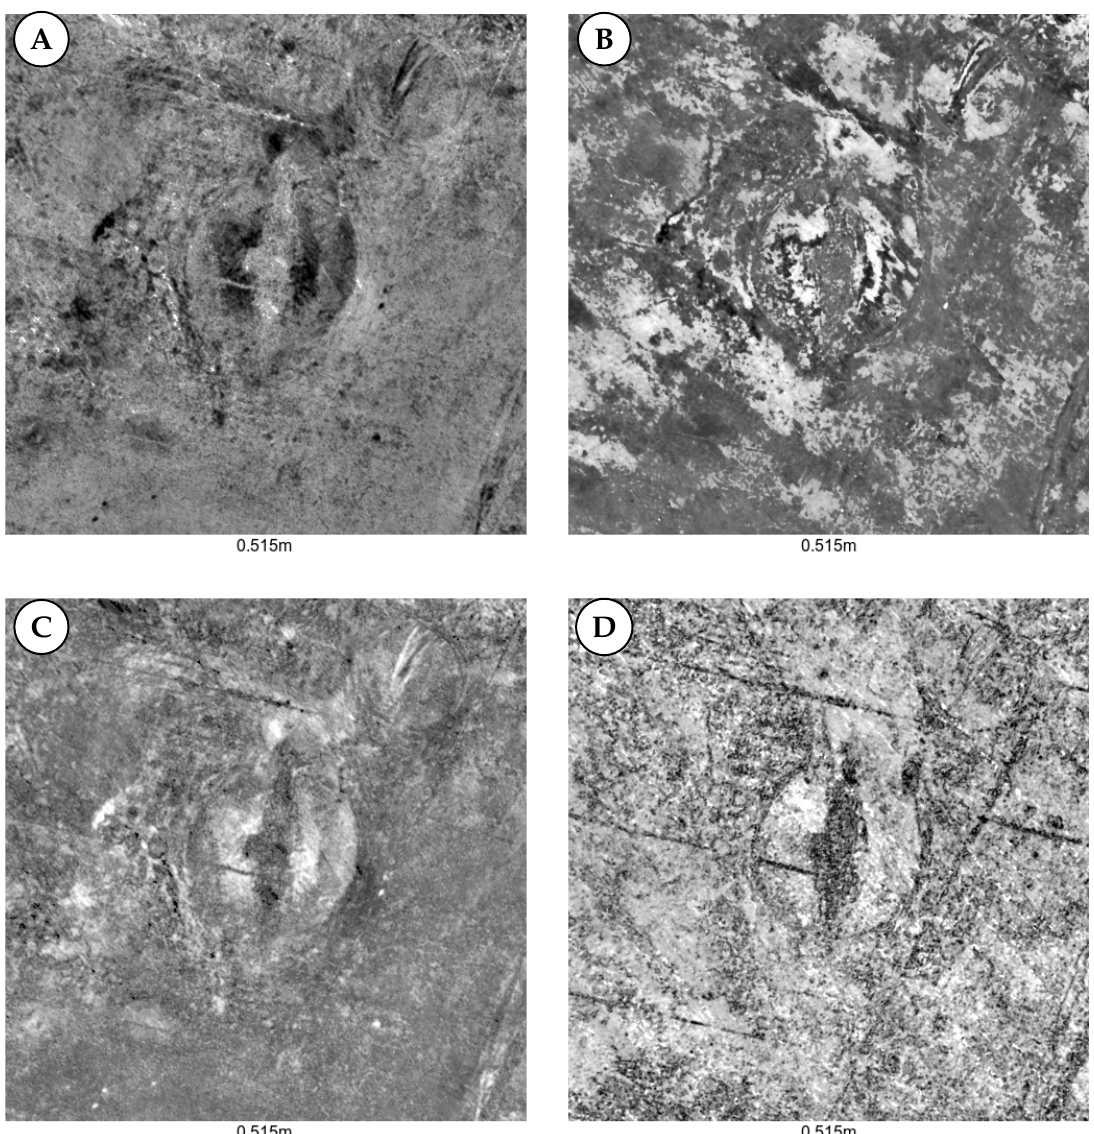
Figure 8. Four visualisations of GPR depth-slices (approx.51.5cm depth) from the overploughed burial mound with the remains of the Gjellestad Viking ship. North is upwards. ( A ) Standard amplitude map after Hilbert transformation. Light areas indicate absorbing structures, dark areas increased reflectivity. ( B ) Single-sample full amplitude slice. ( C ) Inverse image of ( A ). ( D ) Coherence